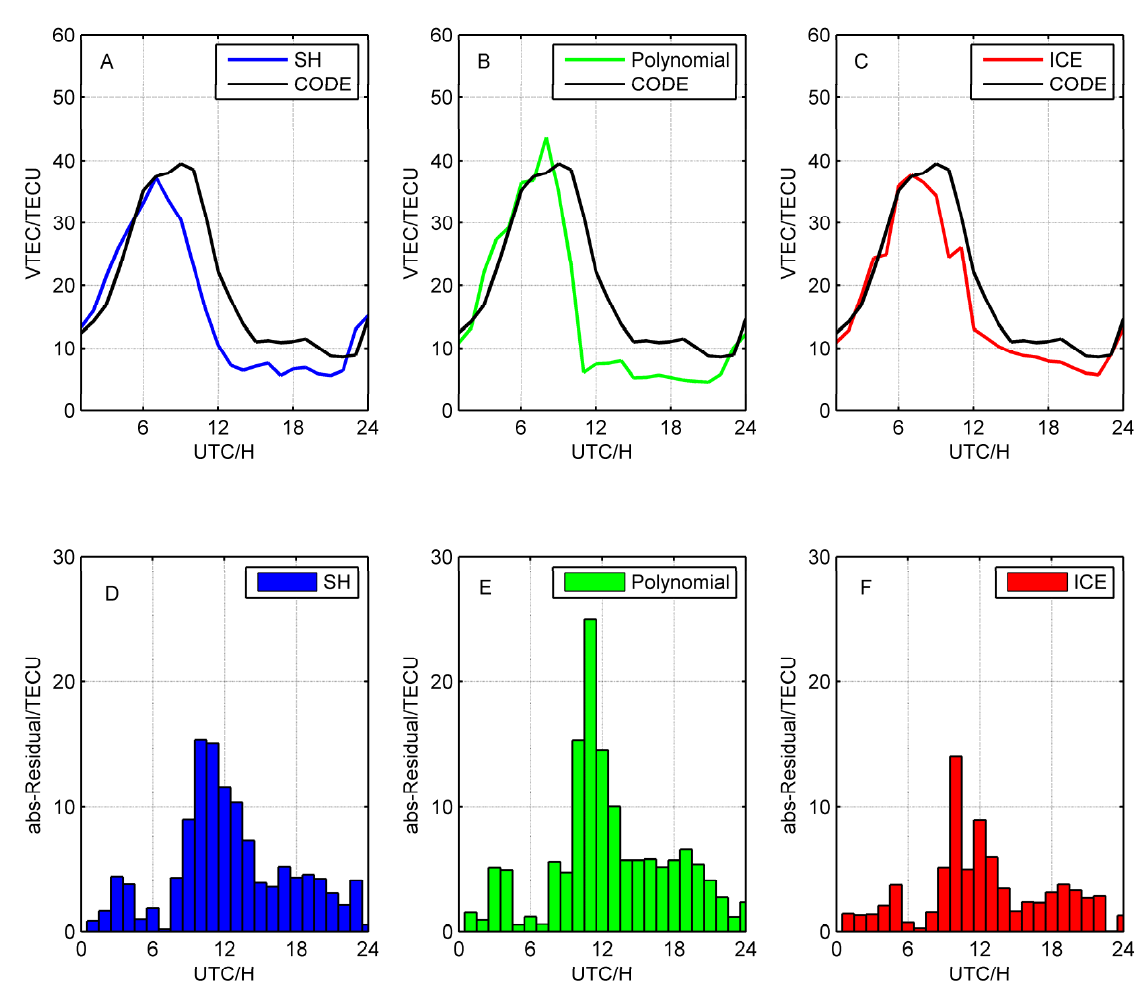
Figure 12. Performance analysis of three ionospheric models in low latitudes on the quiet day. The blue, green, and red polylines show the time series of VTEC for SH (panel ( A )), polynomial (panel ( B )) and ICE (panel ( C )) models, respectively, and the black polyline is the time series of the reference value. The blue (panel ( D )), green (panel ( E )) and red (panel ( F )) histograms are the absolute residuals for three models with respect to the reference value, respectively.